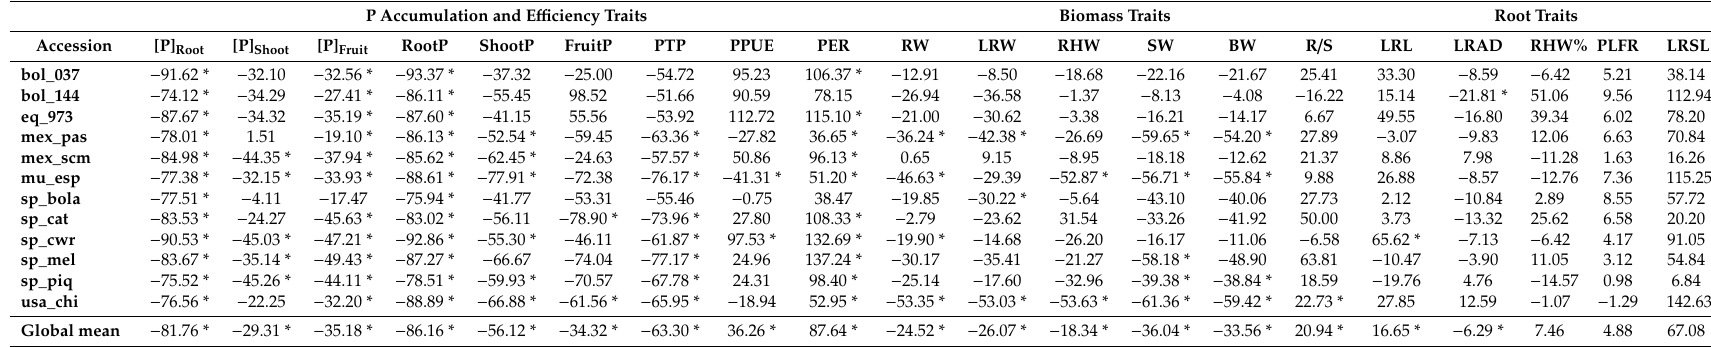
Table 3. Accession behavior given by di ff erences (%) between control and NoP conditions for Trial 1. Twenty di ff erent P accumulation and e ffi ciency ( n = 4), biomass and root traits ( n = 9) and parameters were